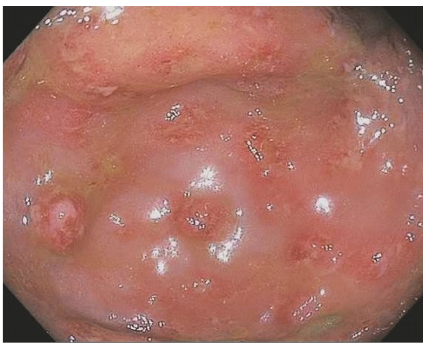
Figure 2: Colonoscopy showing portion of cecum with multiple aphthous ulcers.